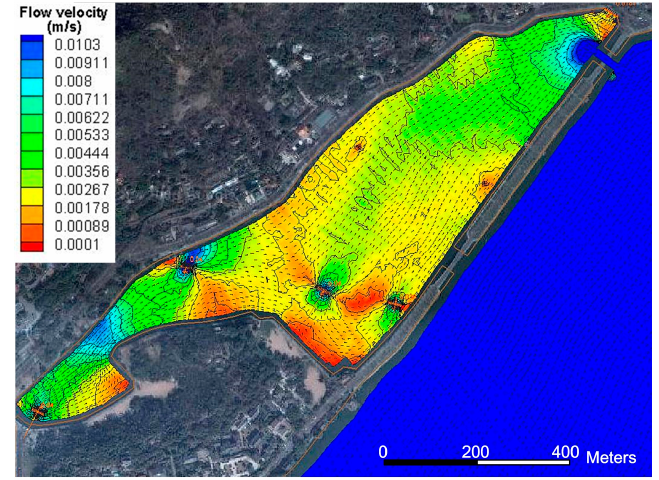
Figure 7. Flow field of Beili Lake after the water diversion and distribution project (10 September 2012).